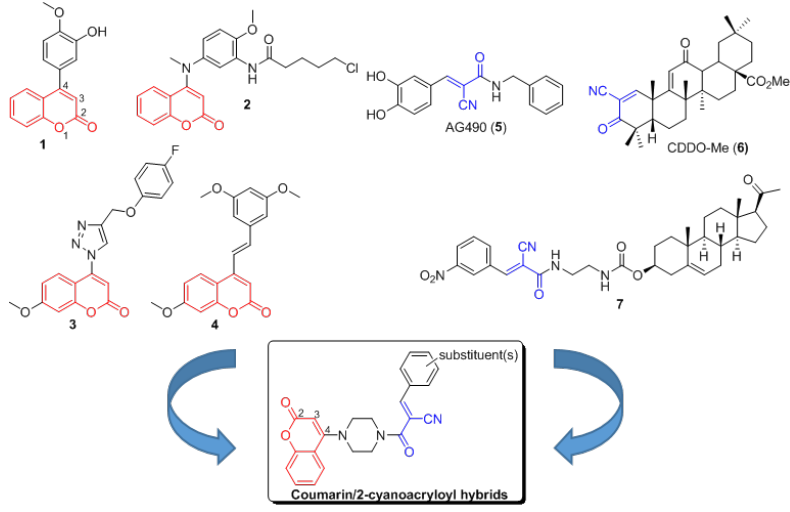
Figure 1. Reported anticancer agents 1 – 7 and designed coumarin/2-cyanoacryloyl hybrids.